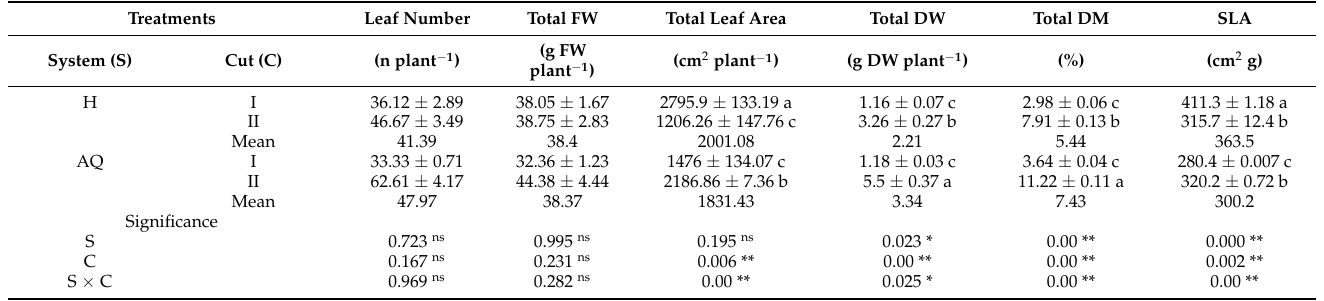
Data represent the mean ± s.e. (n = 3). Different letters indicate significance based on Tukey’s HSD post hoc test. ns, *, **, and *** indicate non-significant and significant effects at p < 0.05, 0.01, and 0.001,